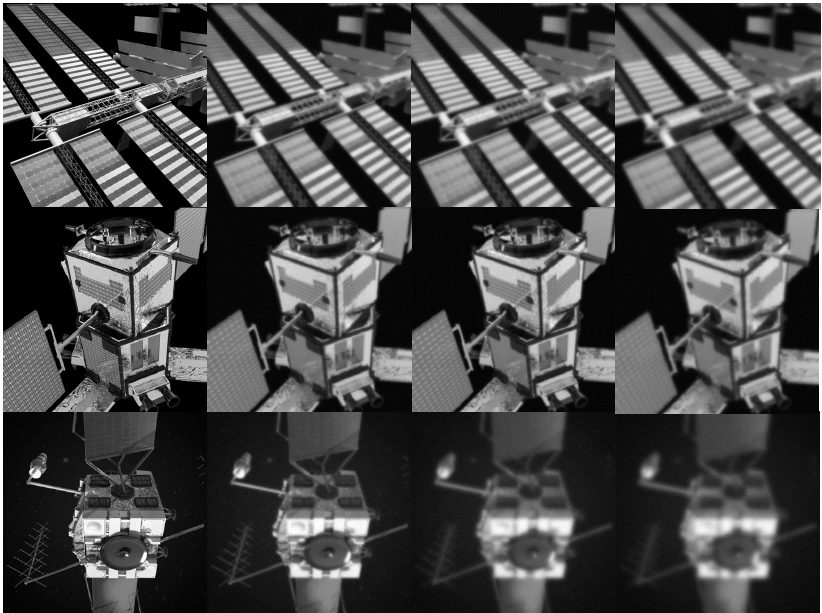
Figure 8. Some simulated data for testing. From left to right: clear; mildly degraded; moderately degraded; and severely degraded.